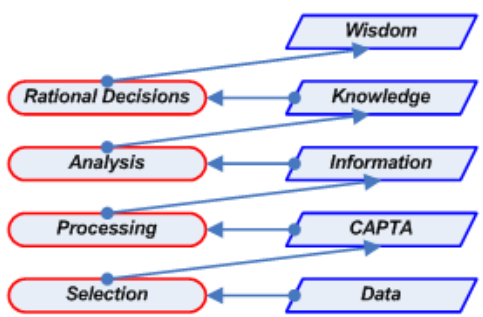
Figure 1. A conceptual model illustrating the progression of data processing from the raw data to wisdom (rational decision-support) (source: